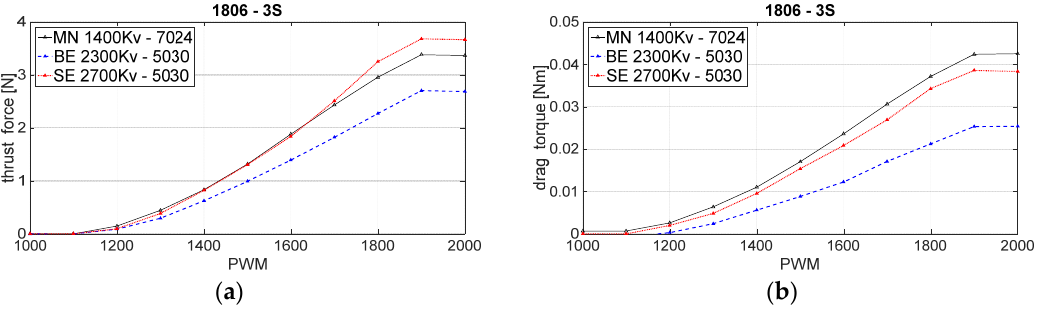
Figure 10. Static maps—1806 BLDC series: ( a ) thrust force; ( b ) drag torque.